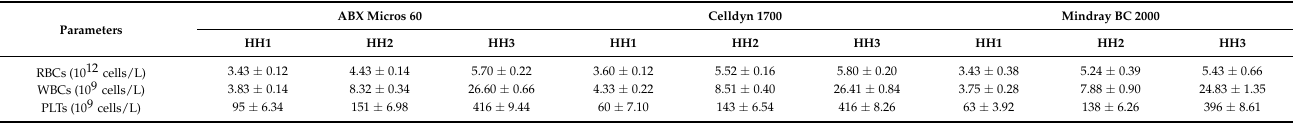
Table 2. Assigned value of three concentration levels on three hematology analyzers using an electronic impedance method.